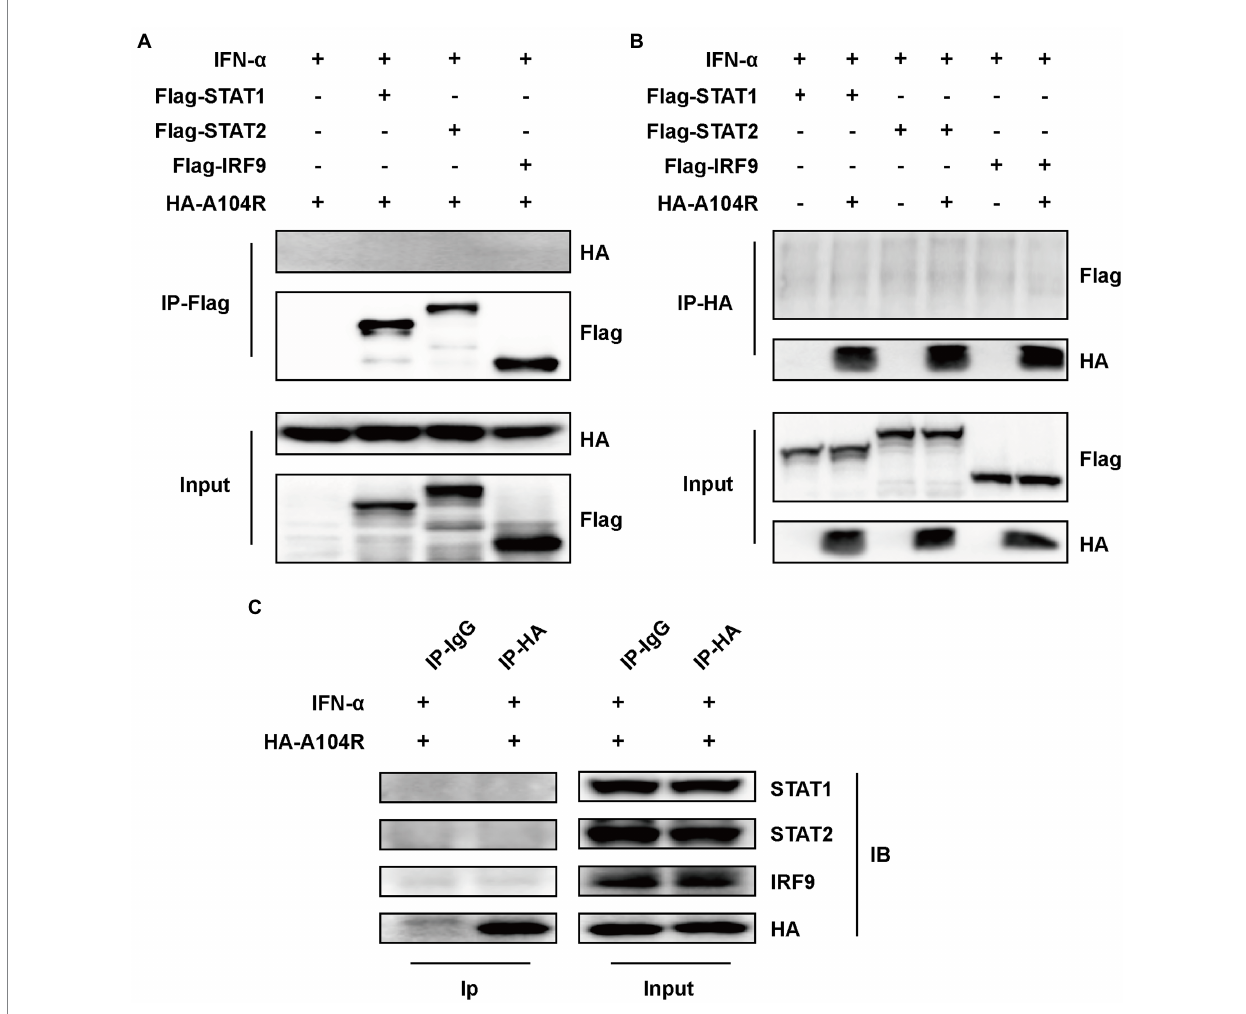
FIGURE 3 ASFV pA104R does not interact with STAT1, STAT2, and IRF9. HEK-293 T cells were transfected with pA104R alone (C) or co-transfected with STAT1, STAT2, and IRF9 (A , B) . After 24 h, cells were treated with 1,000 U/mL IFN- α for 8 h. Cell lysates were prepared and subjected to immunoprecipitation analysis. The whole-cell lysates and immunoprecipitation complexes were analyzed by immunoblotting with the indicated